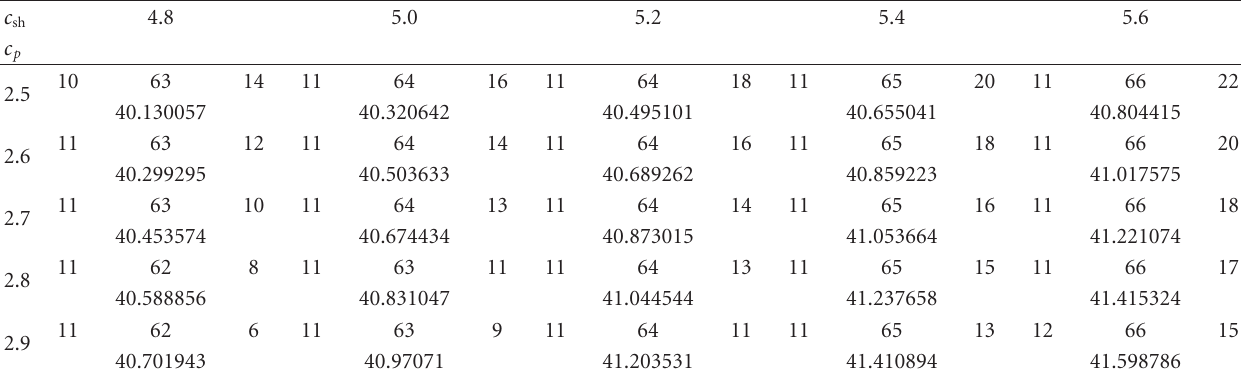
Table 18: Variation in optimal values for di ff erent values of c p and c sh ( c s = 15, c h = 0 . 3, c pr = 0 .